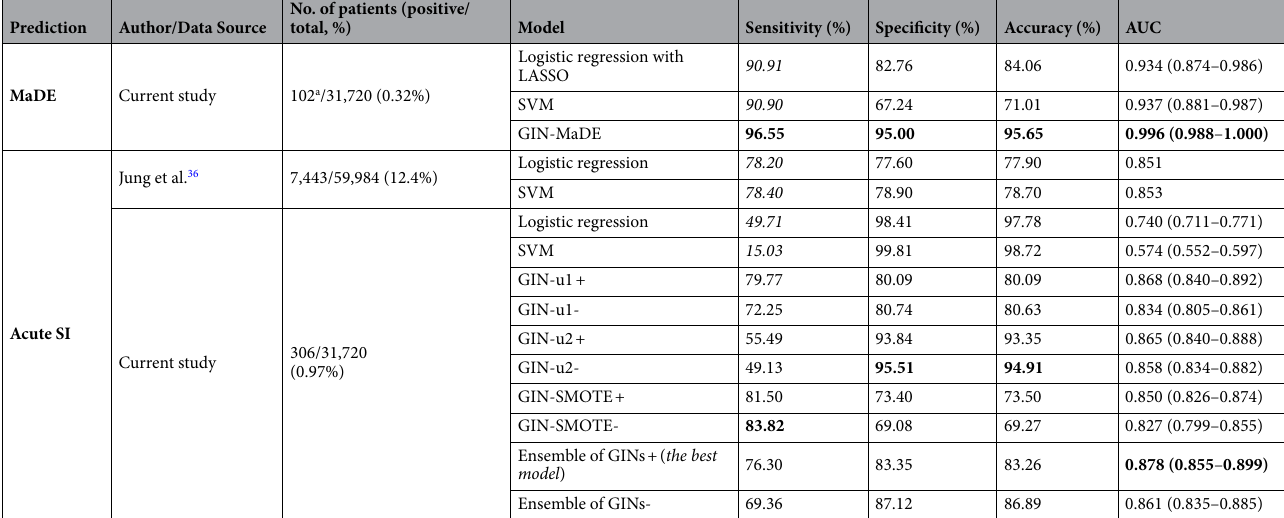
Attention plots and interpretation. The raw averaged attention plots without normalization are given in Fig. 2 for the test set (Fig. 2a). In the attention plot comparing questionnaire items using row-wise normaliza- tion (Fig. 2b), a high score (i.e., 4 points) for Item 2 of the PHQ-9 (i.e., PHQ_2, anhedonia) was the most salient positive feature (i.e., a feature that increases the prediction score of acute SI) among the 19 items of the ques- tionnaires. The second most salient positive feature was a high total score for the STAI-S (i.e., the 4th quartile group), which represents a high level of anxiety. For low score (i.e., 1 point, the 1st quartile group), the most salient negative feature (i.e., a feature that decreases the prediction score of acute SI) was a low total score for the STAI-S and a low PHQ_2 score, which means that a low level of anxiety and anhedonia are the most significant feature associated with reduced SI. For intermediate scores (i.e., 2–3 points), the salient positive features were PHQ_5, PHQ_6, and PHQ_8 (i.e., psychomotor symptoms, feeling tired, and trouble concentration on things, respectively) to a similar degree. In PHQ_9, thought that would be better off dead or of hurting, the 1st quartile group decreased SI while the 2nd to 4th showed the opposite result. Point 1 or 2 in RAS total score was the sali- ent negative feature for SI, which means that the 3rd or 4th quartile groups (because of reversed order) of RAS total points decreased SI. In the attention plot comparing binary items using column-wise normalization (Fig. 2c), the attention values were highest for lifetime SA (odds ratio (OR), 13.69), presence of MaDE (OR, 3.81), female (OR, 3.74), and type of institution (OR, 2.10). In the plot using the L1-norm of the attention vector, obtained for each column of the 19 questionnaire items (Fig. 2d), the attention values were the highest for PHQ_2 (1.0) and STAI-S had the 2 nd highest attention values (0.937). The RAS and PHQ_5 had the 3 rd and 4 th highest attention values (0.857 and 0.792), respectively. Moreover, the attention plots for the training/validation set showed nearly identical results to those for the test set (Supplementary Fig. 3a–d). Ablation study for PHQ‑9 item 9.